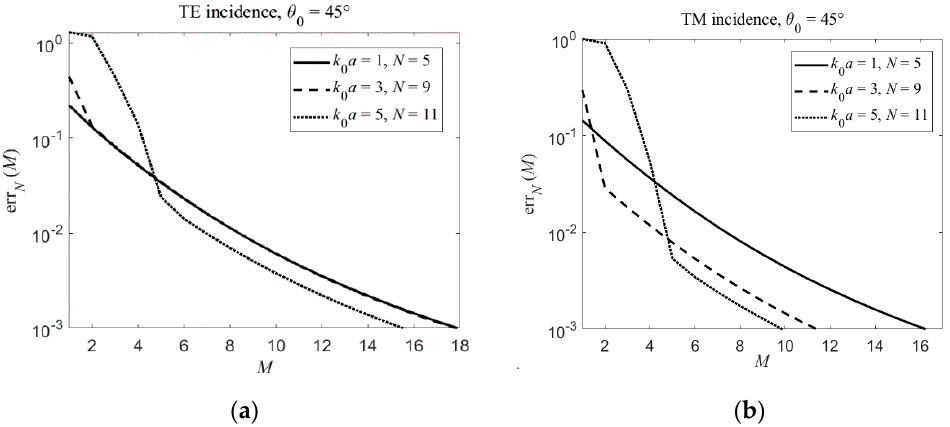
1,3,5 k a = ). Figure 2. Normalized truncation error for disks with di ff erent radii ( k = 1,3,5). N = 5,9,11, τ = 0.05 a , 0 0 a